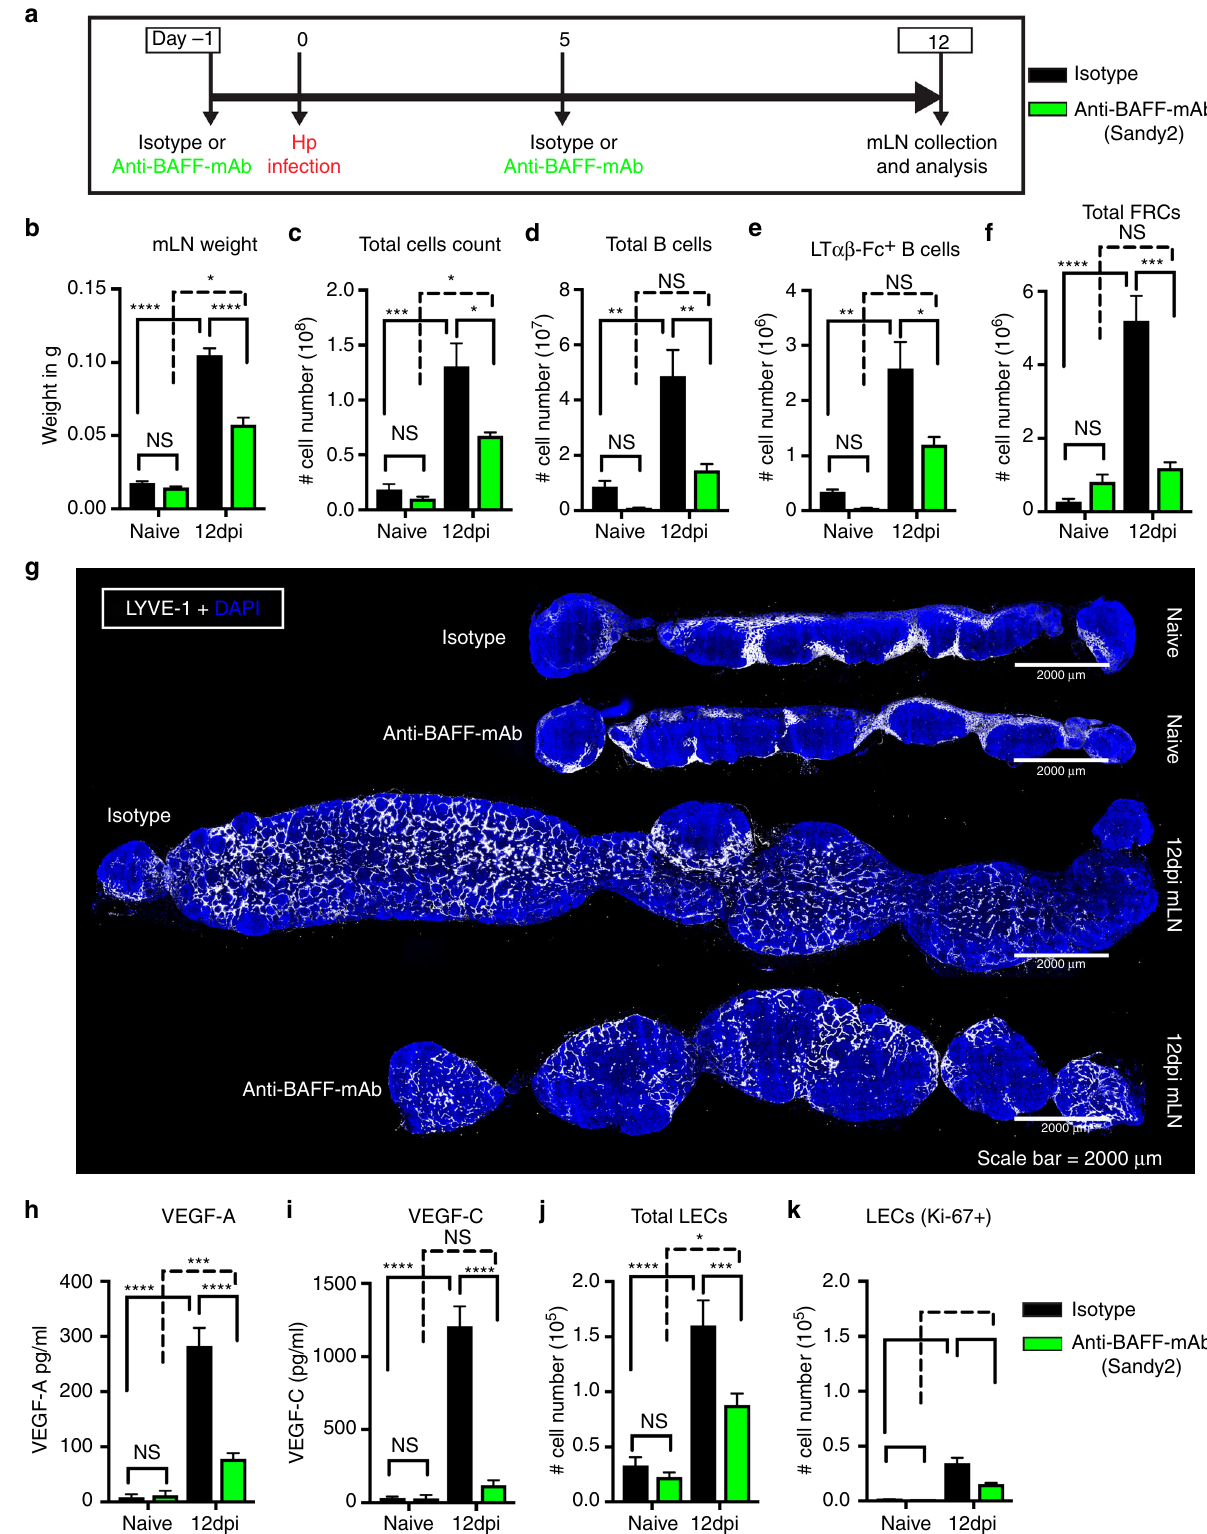
(Fig. 6d), and activation of FRCs by lymphotoxin-expressing B cells is required for BAFF expression (Fig.